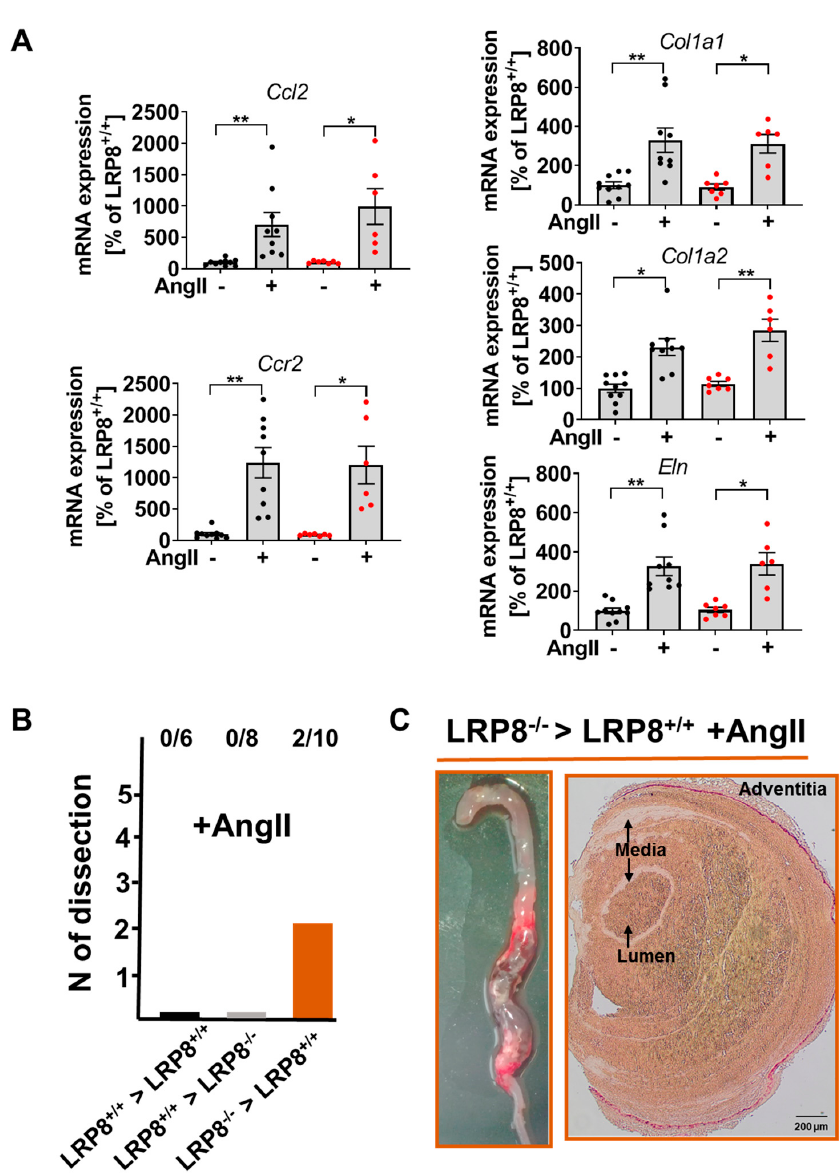
Figure 3. Critical role of myeloid cells to drive aortic dissection in AngII infused LRP8 − / − mice. ( A ) Aortic mRNA expression of Ccl2, Ccr2, Col1a1, Col1a2 and Eln . One dot corresponds to one aorta of one animal. n = 6 – 10 animals/group. Data are presented as mean ± SEM; * p < 0.05, ** p < 0.01; vs. sham